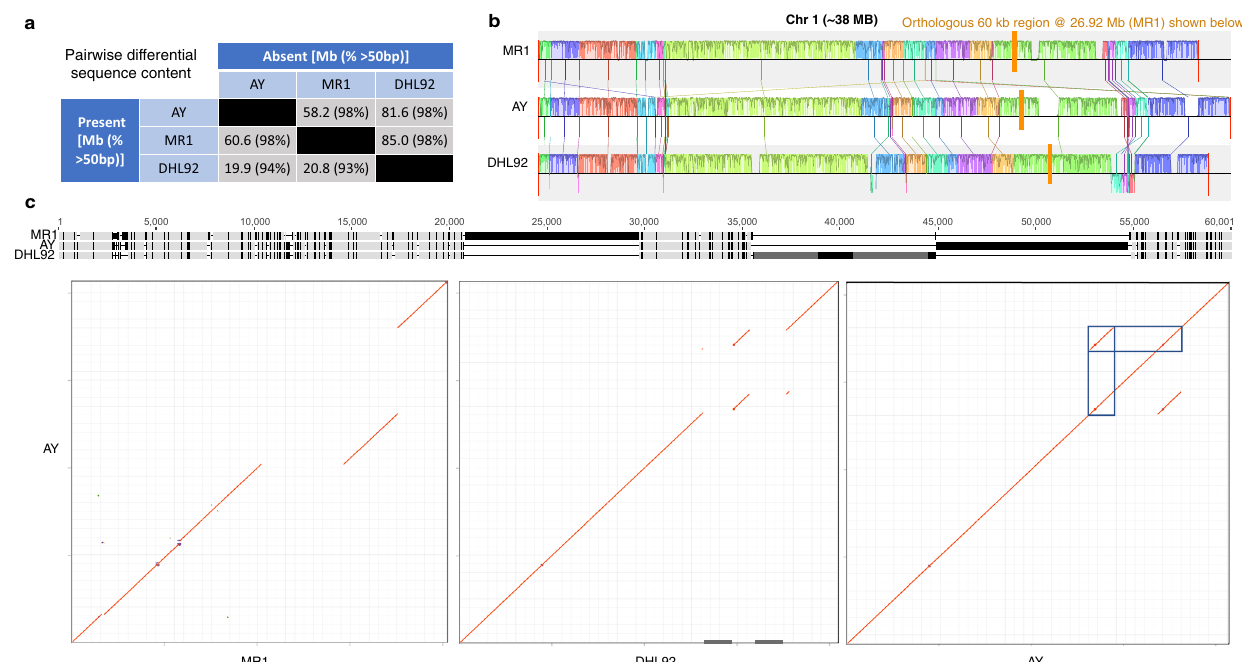
Fig.1|Pangenomeofthreemelonsequencesandsourcesofgenomicsequence. a Relative presence/absence of genome sequence is depicted for pairwise compar- ison(basedonmulti-sequencealignments).Onlyvariants>50bpareshownbuttheir percentage of the total is indicated parenthetically. b Chromosome-scale MSA of Chr01. Sequences do not contain gaps and so are spatially offset. See mauve viewer for details (https://darlinglab.org/mauve/user-guide/viewer.html). Colors re fl ect locally collinear blocks. Rare, relative inversions appear below the forward strand